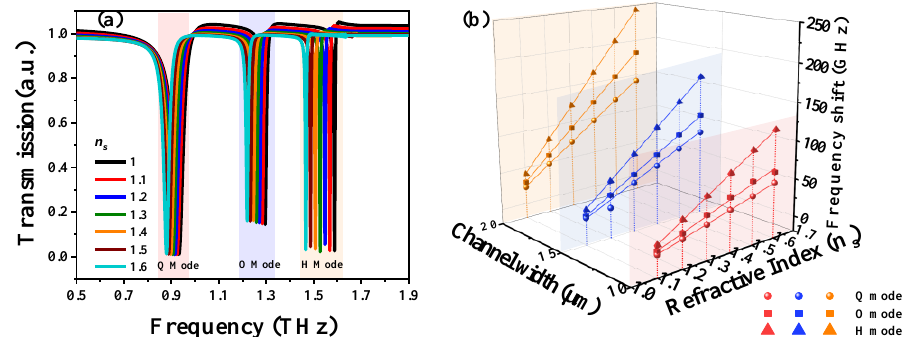
Figure 7. ( a ) Transmission spectra of SSM integrated with a microfluidic chip. The chemical solutions with different refraction indexes ( n s ) are injected into the microfluidic channel with a channel width of 10 μm. ( b ) Summaries of relationships between frequency shifts, n s values and channel widths.